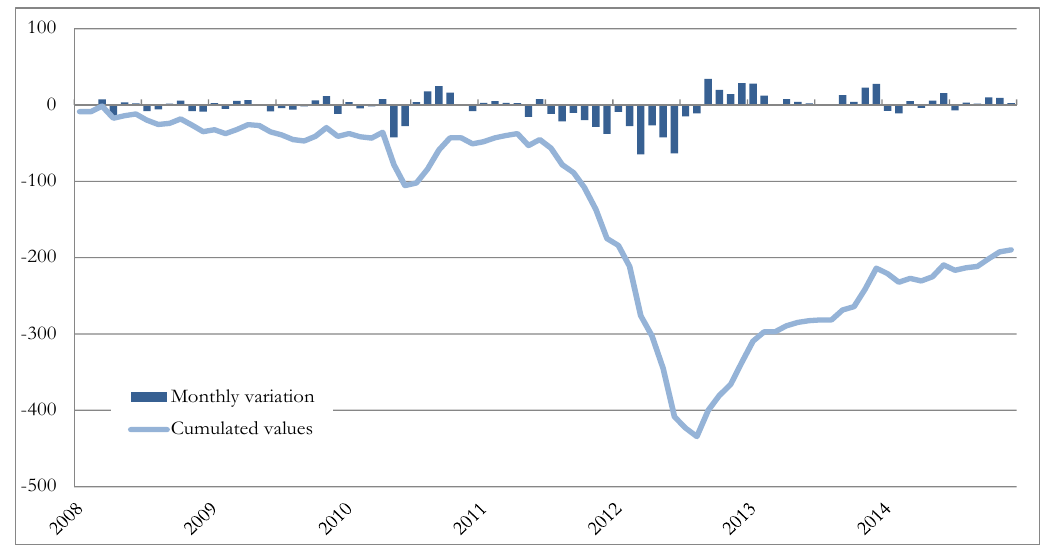
Figure 5. TARGET2 balances towards the Eurosystem, Spain (Euro billion, monthly, end of the period). Source: Elaboration on the “Institute of Empirical Economic